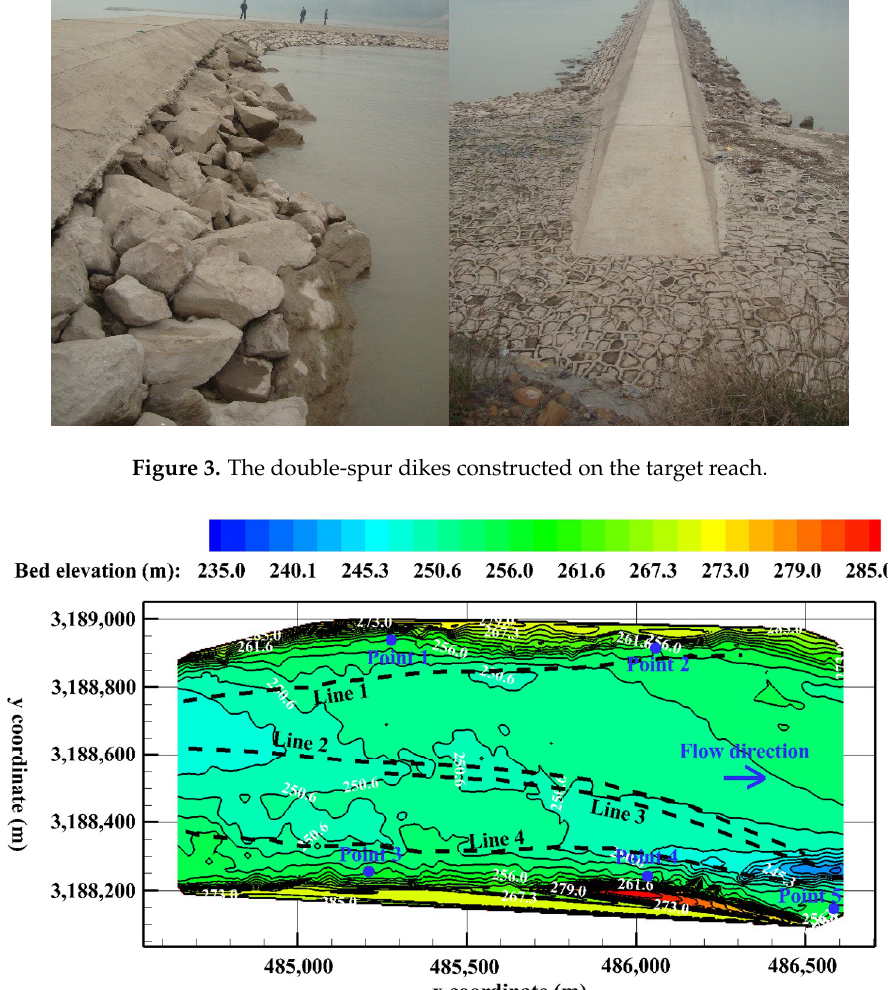
Figure 4. Terrain contours of the target reach before the spur dikes’ construction (the datum is the sea level, and gray dashed lines and blue dots show the locations of flow velocity and water elevations being observed).